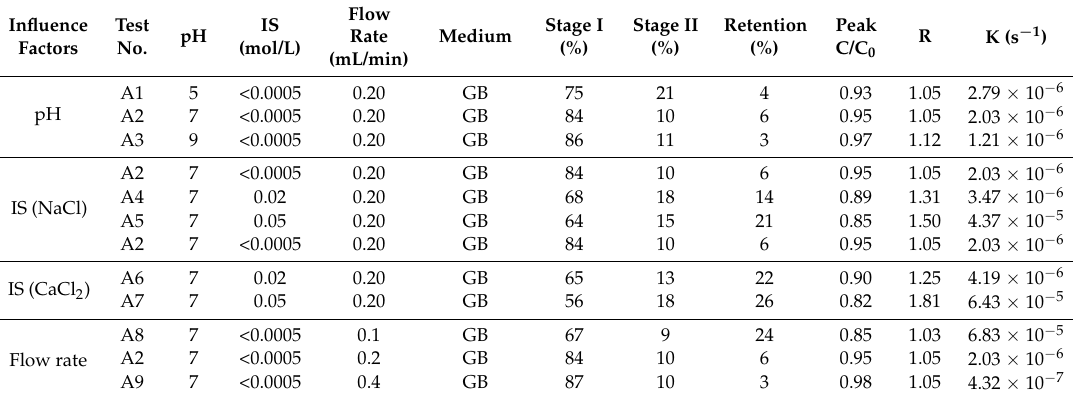
Table 2. Experimental conditions and part results for column tests.